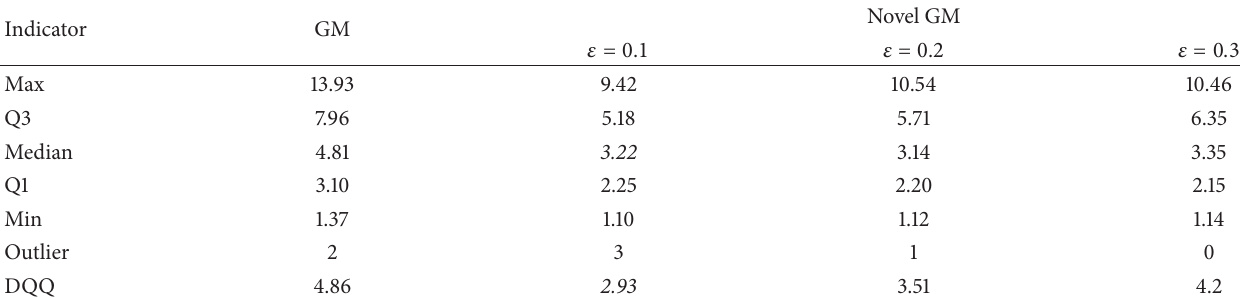
Table 4: Values of indicators in box plot of RMSEs at different values of 𝜀 in the novel GM and GM. Indicator